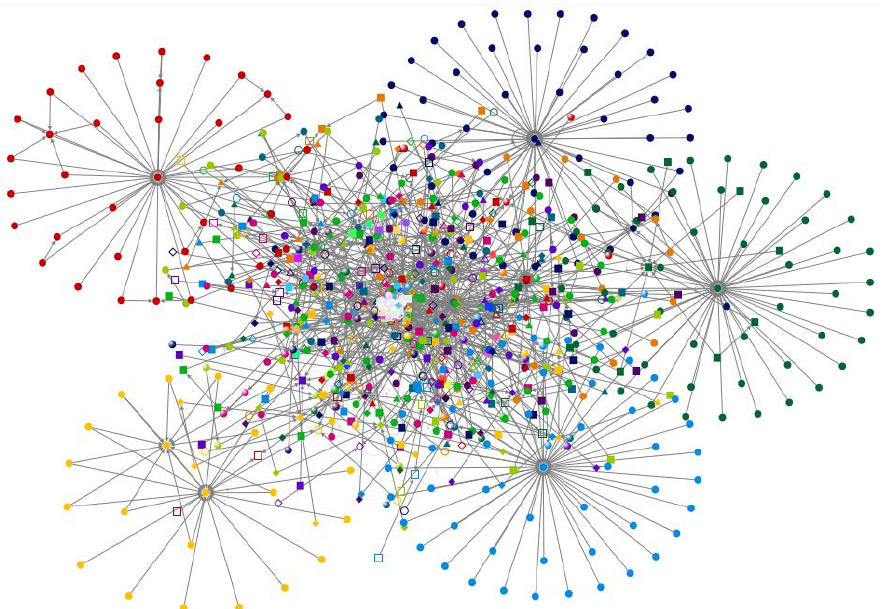
Figure 2. Layout of the top five categories displayed.